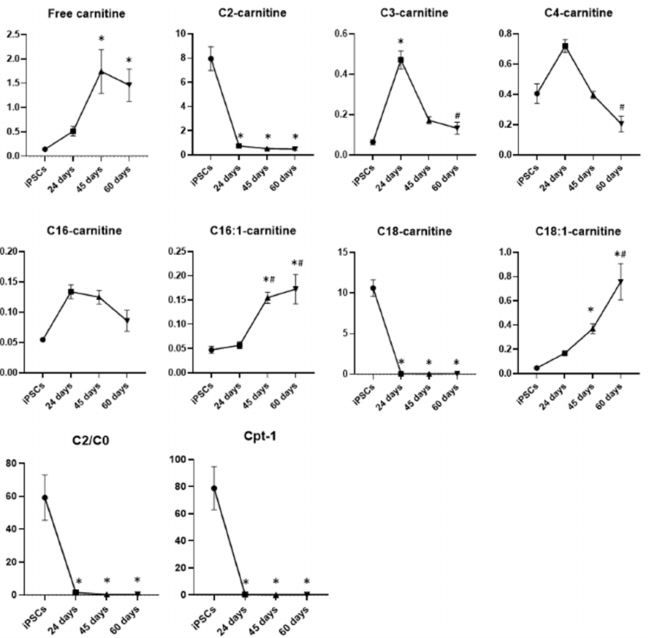
Figure 9. Graphic representation of the major metabolic changes related to fatty acid β -oxidation in iPSCs and DA neurons at days 24, 45 and 60 of differentiation. Data represent mean ± SEM from at least triplicates of cultures from iPSCs and DA neurons at days 24, 45 and 60 of differentiation: C0, free carnitine; C18-carnitine, ocatadecanoyl carnitines; C16-carnitine, hexadecanoylcarnitines; C2- carnitine, acetylcarnitines; C3-carnitine, propionylcarnitines; C4-carnitine, butyrylcarnitines; C18:1- carnitine, octadecenoylcarnitine; C16:1-carnitine, hexadecenoylcarnitine; Cpt-1, carnitine palmitoyl transferase 1. * Significant v. iPSCs, # significant v. 24